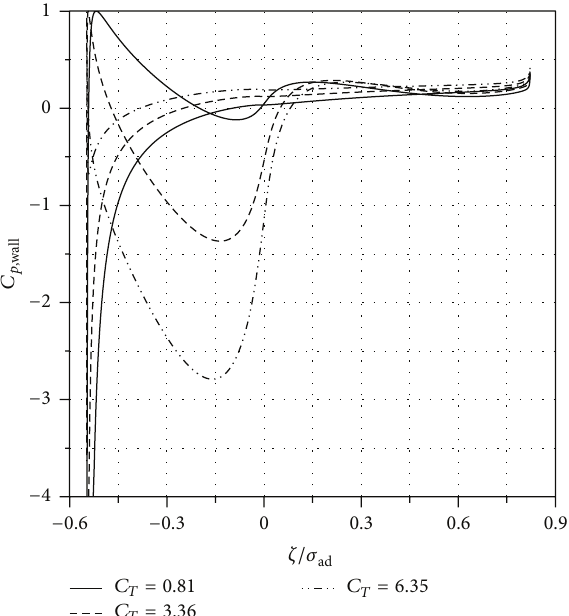
Figure 7: Wall pressure coefficient distribution along the duct NACA